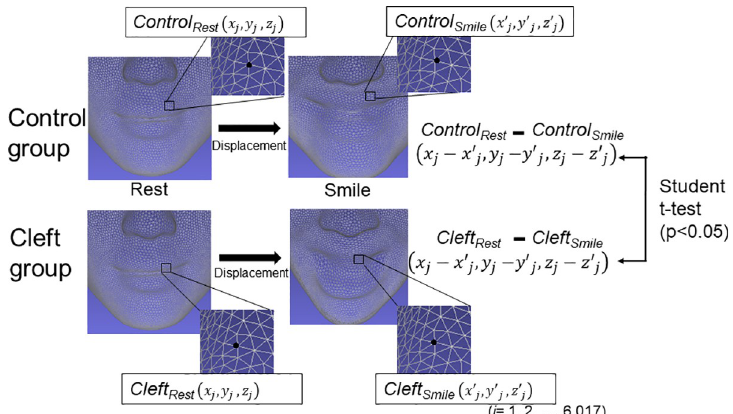
Fig 3. Schematic illustration of the statistical comparison of the displacements from a rest position to the peak maximum smile position between the Control group and Cleft group. Control rest faces at rest in the Control group; Control smile , faces at the peak of smiling in the Control group; Cleft rest , faces at rest in the Cleft group; Cleft smile , faces at the peak of smiling in the Cleft group.